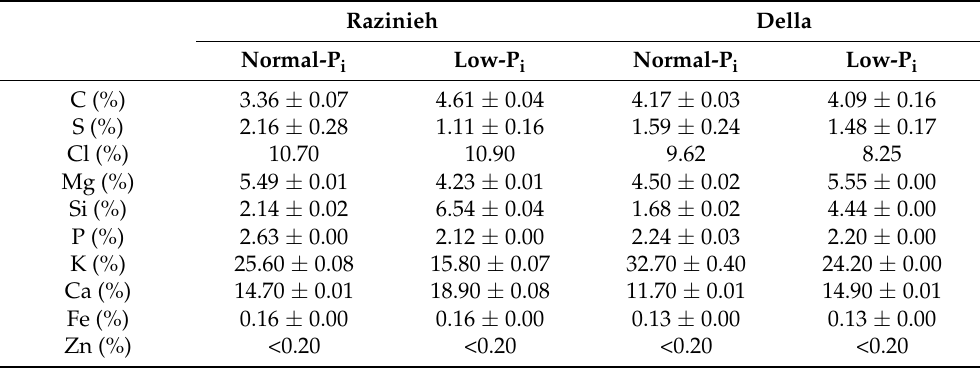
Ca (%) 14.70 ± 0.01 18.90 ± 0.08 0.16 ± 0.00 Data in wt% or mg/kg dry matter; normal Pi: plants grown in Pi-supplemented soil (40 mg/100 g) up to maturity; low Pi: plants grown in Pi-depleted soil (4 mg/100 g) up to maturity. (For Cl, only 1 analysis was possible due to the small sample amount.) Values are means ± standard